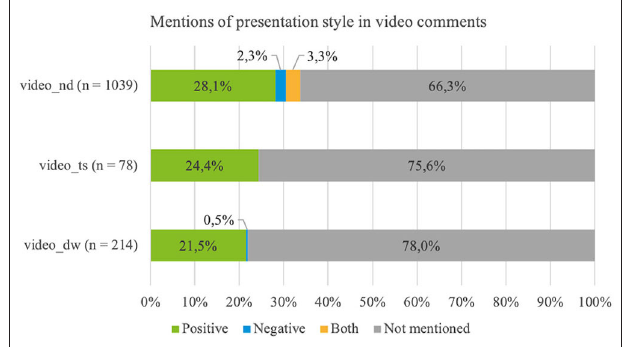
FIGURE 3 | Categorization of viewer’s comments on the three case study videos with respect to the comprehensibility.